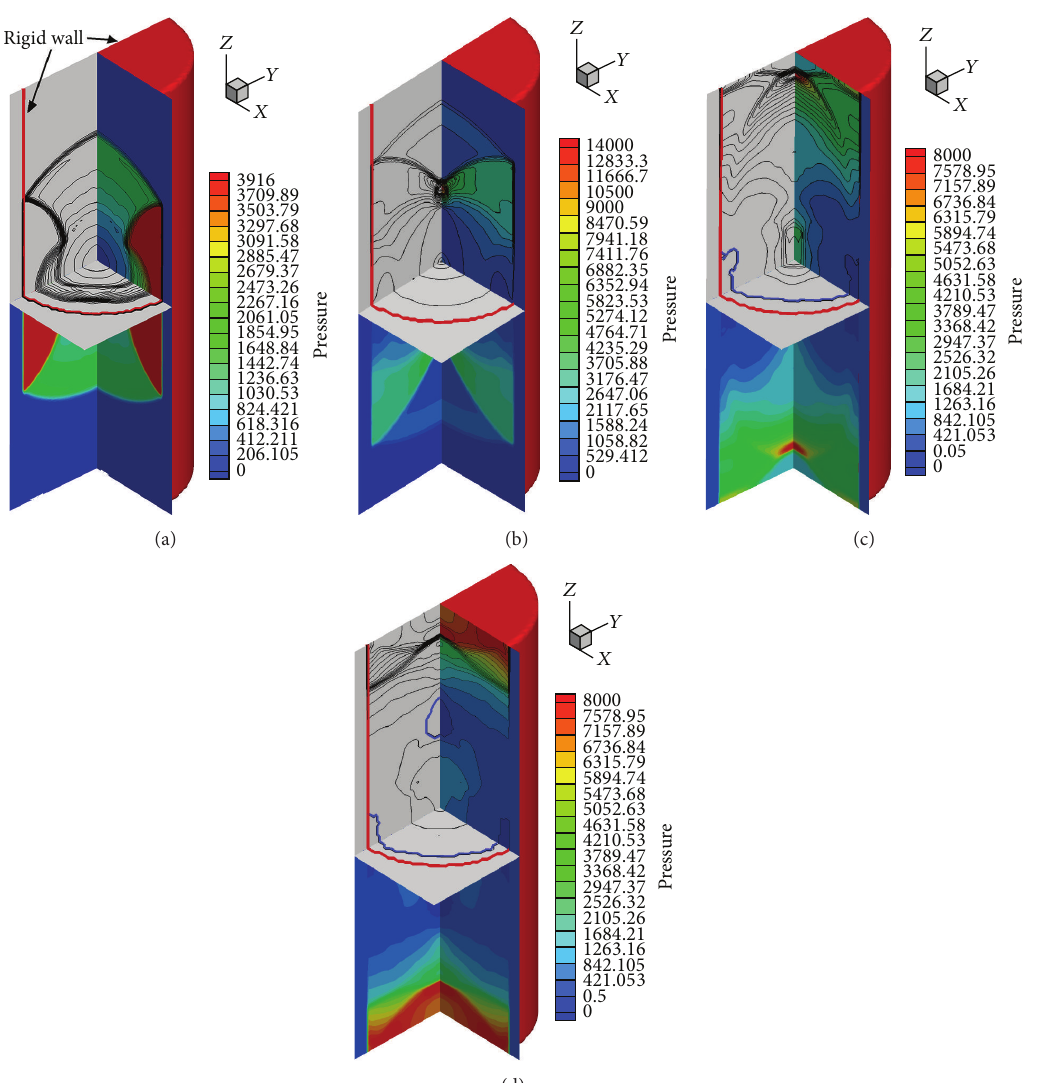
Figure 12: Pressure cloud pictures and contours by GFM-based algorithm. Blue lines indicate the cavitation region. Red curved surface and red lines represent rigid wall, (a) 𝑡 = 30 𝜇 s, (b) 𝑡 = 40 𝜇 s, (c) 𝑡 = 60 𝜇 s, and (d) 𝑡 = 70 𝜇 s (Case